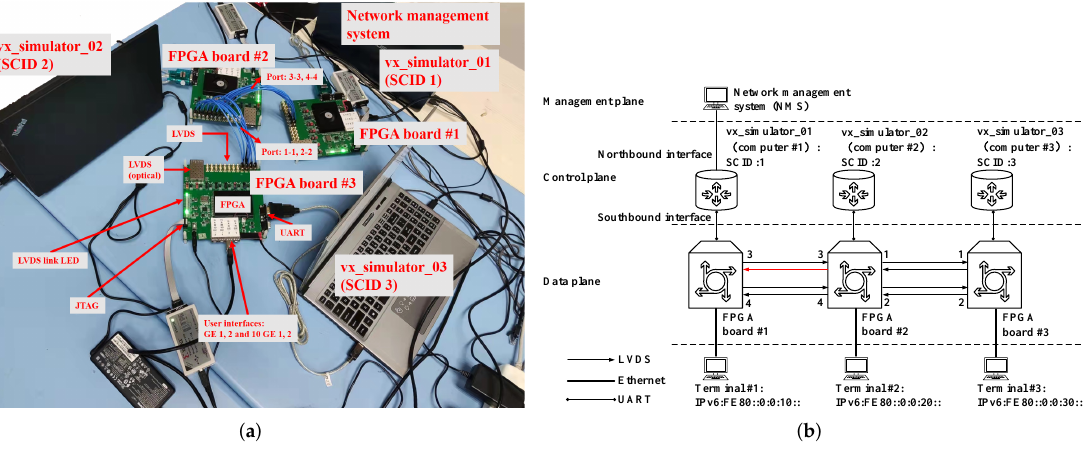
Figure 14. The semi-physical platform. ( a ) The semi-physical platform with VxWorks simulated nodes and FPGA boards. ( b ) The network topology of the semi-physical